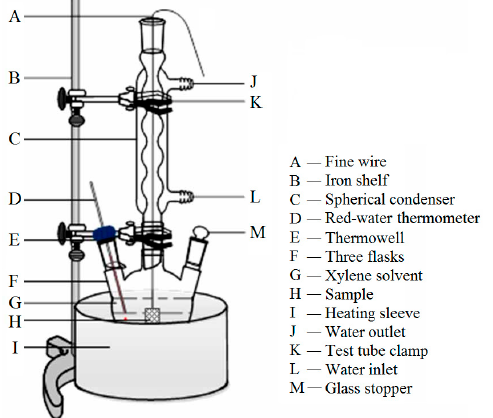
Figure 3. Schematic equipment of gel extraction experiment.